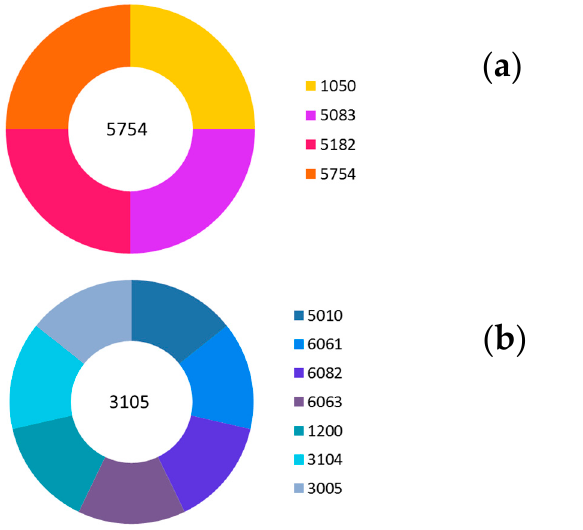
Figure 2. Graph showing the combination of aluminum alloys in order to produce ( a ) 5754 alloy and ( b ) 3105. Table 2. Chemical composition of the new 5754 and 3105 alloys and their difference s with standard composition.